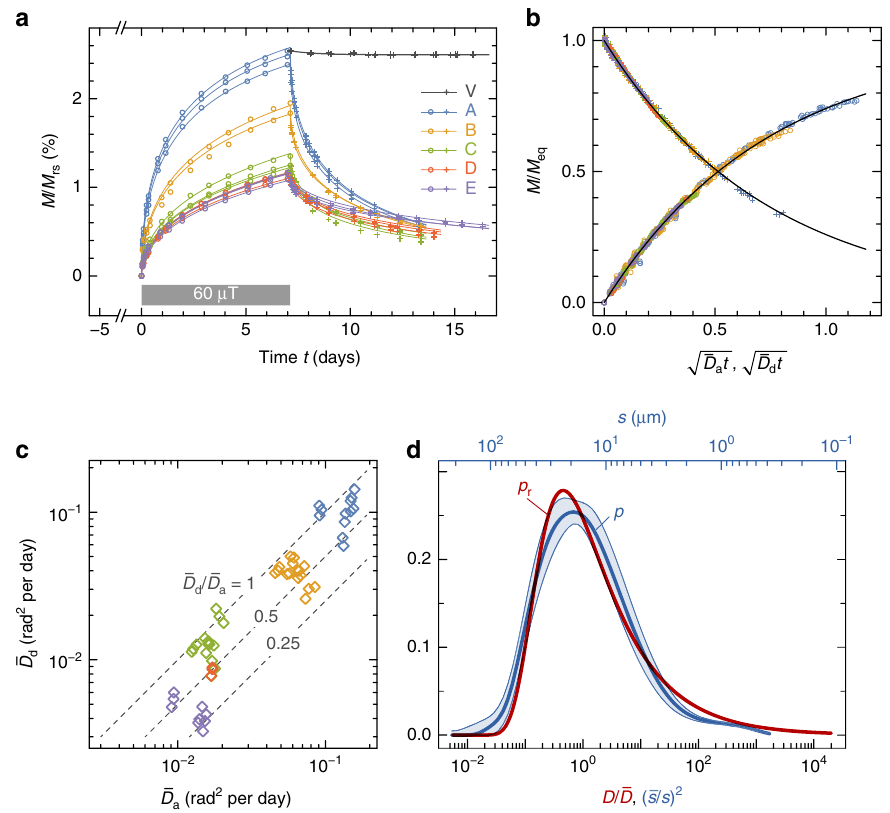
Figure 3 | PDRM acquisition results. ( a ) Magnetization versus time for the sediment groups A–E (circles, crosses), after normalization by the mean saturation remanence M rs . The sediments were deposited in a null field (day (cid:2) 5 to day 0). A 60- m T field with 50 (cid:2) inclination was applied during the next 7 days and was turned off thereafter. Lines are best-fit model curves obtained from equations (2 and 3). Group V designates the PDRM decay due to magnetic viscosity in three fully dried samples, where particle reorientation was not possible. ( b ) PDRM acquisition for the groups A–E in 20-, 40-, 60-, 80-, 100- and 150- m T fields and subsequent zero-field decay. Magnetizations are normalized by the equilibrium PDRM ( M eq ) that would be reached after an infinite time. Acquisition/decay times are normalized by the median rotational diffusion coefficients, (cid:2) D a and (cid:2) D d , as deduced from least-squares fits of the measured curves (Supplementary Note 1). All data collapse onto a single acquisition/decay curve (black lines), as expected when the rotational diffusion coefficients are identically distributed. ( c ) Median rotational diffusion coefficients (cid:2) D a and (cid:2) D d deduced from individual acquisition/decay curves of the sediment groups A–E. (cid:2) D a has been corrected for the effect of field intensity (Supplementary Note 1). Dashed lines indicate constant values of (cid:2) D d = (cid:2) D a , with (cid:2) D (cid:2) D d = a ¼ 1 expected for stationary conditions. ( d ) Probability density function p r of the rotational diffusion coefficient D , reconstructed from the normalized acquisition/decay curves shown in b , and the mean distribution p of particle diameters s for the sediment groups A–E (the shaded band corresponds to